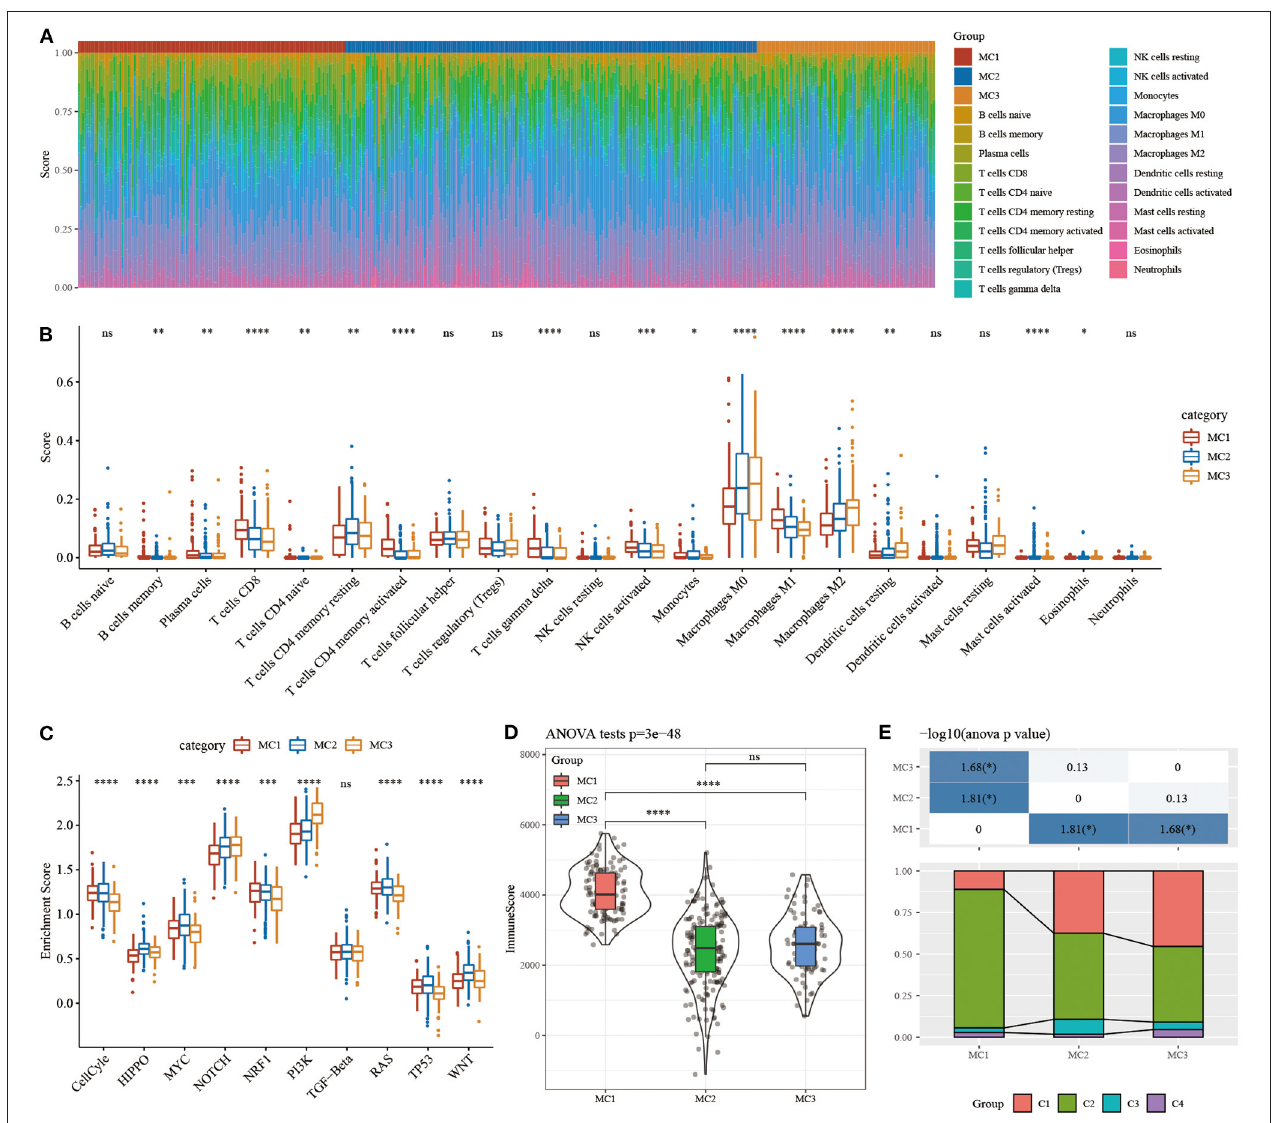
FIGURE 5 | (A) The ratio of 22 immune cell components in samples of different subtypes. (B) Differences in 22 immune cell components of samples in different subtypes; (C) Differences in scores of 10 pathways related to tumor abnormalities in different subtypes; (D) Differences in immune infiltration scores in different subtypes. (E) Comparison of the three metabolic molecular subtypes with the previous six pan-cancer metabolic molecular subtypes. ns, no significance. * P < 0.05, ** P < 0.01, *** P < 0.001, **** P <